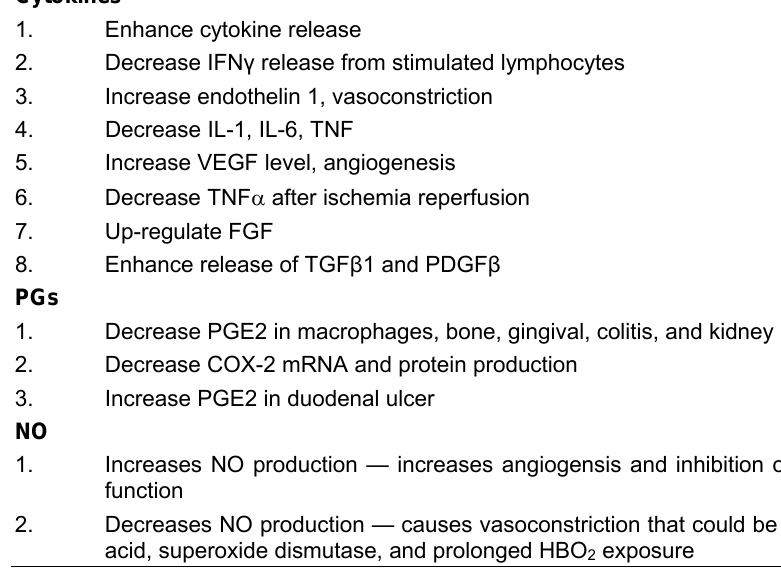
Some Effects of HBO on Biological Mediators of Inflammation and Wound 2